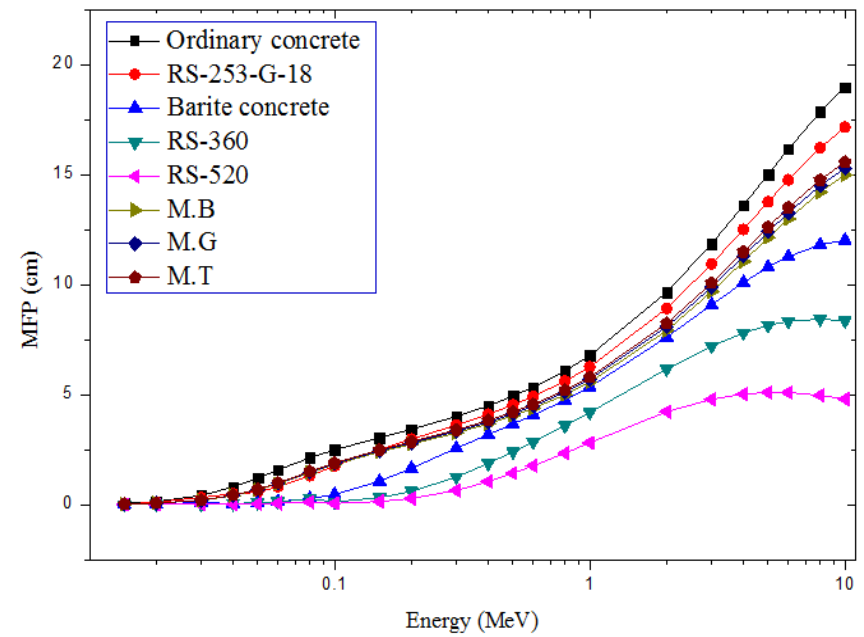
Figure 6. Comparison of MFP of the marble samples with orthodox photon shields.